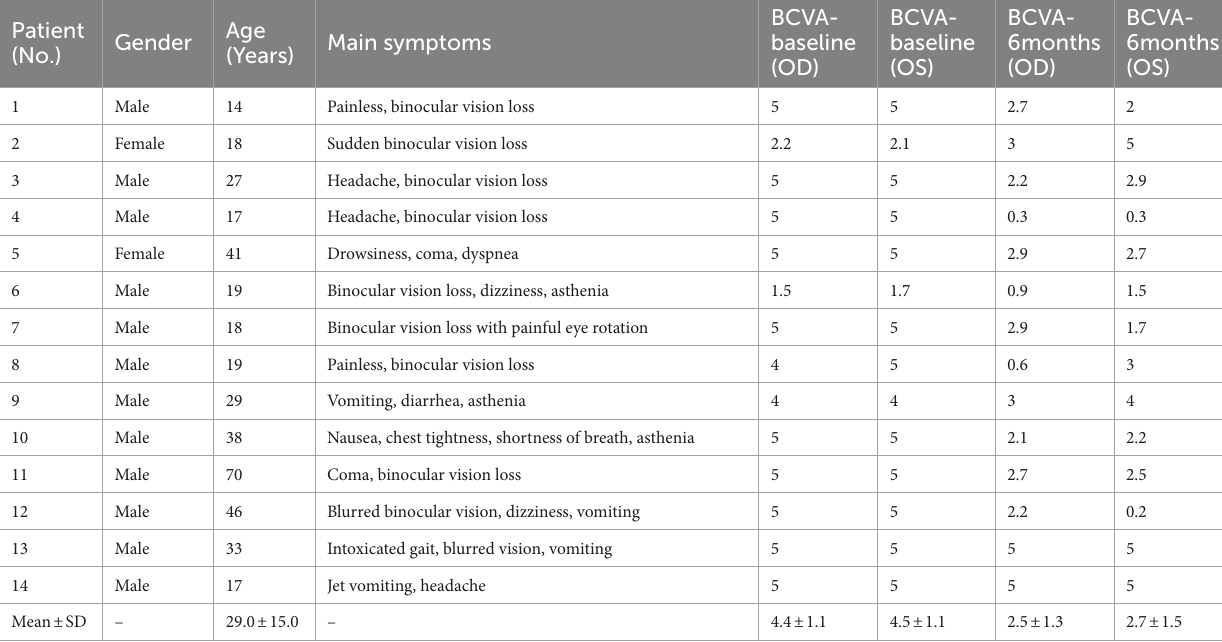
TABLE 1 Basic information for patients with inhalational methanol poisoning. Patient